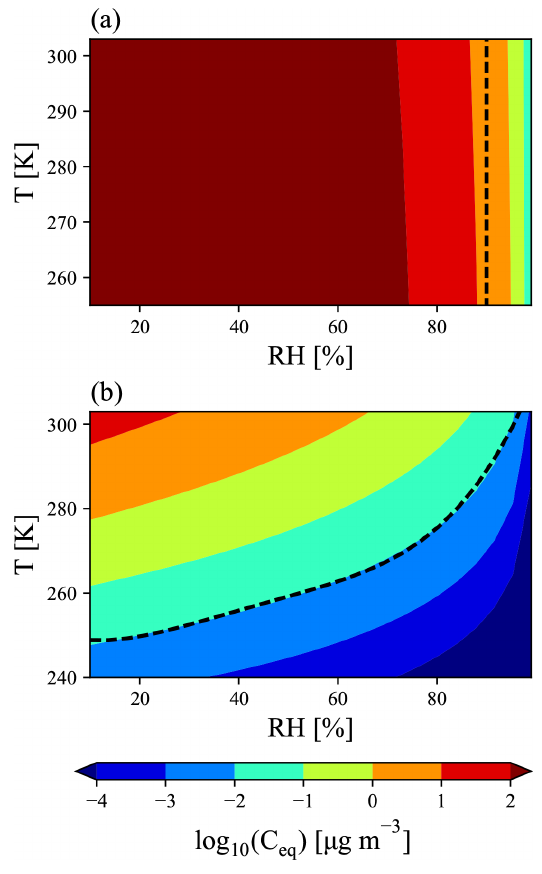
Figure 1. E-AIM prediction of MSA equilibrium vapor pressure above the particle mixture ( C eq ) under conditions with (a) no free ammonia and (b) high free ammonia (3 times as many moles of ammonia as MSA). (a) The dashed line at 90%RH indicates the cut-off for representing MSA as a VOC-like (left of the line) or an SVOC-like (right of the line) species. (b) The dashed line is de- scribed by Eq. (1) in the text. Above the dashed line, MSA is treated as an SVOC-like species; below the dashed line, MSA is treated as an ELVOC-like